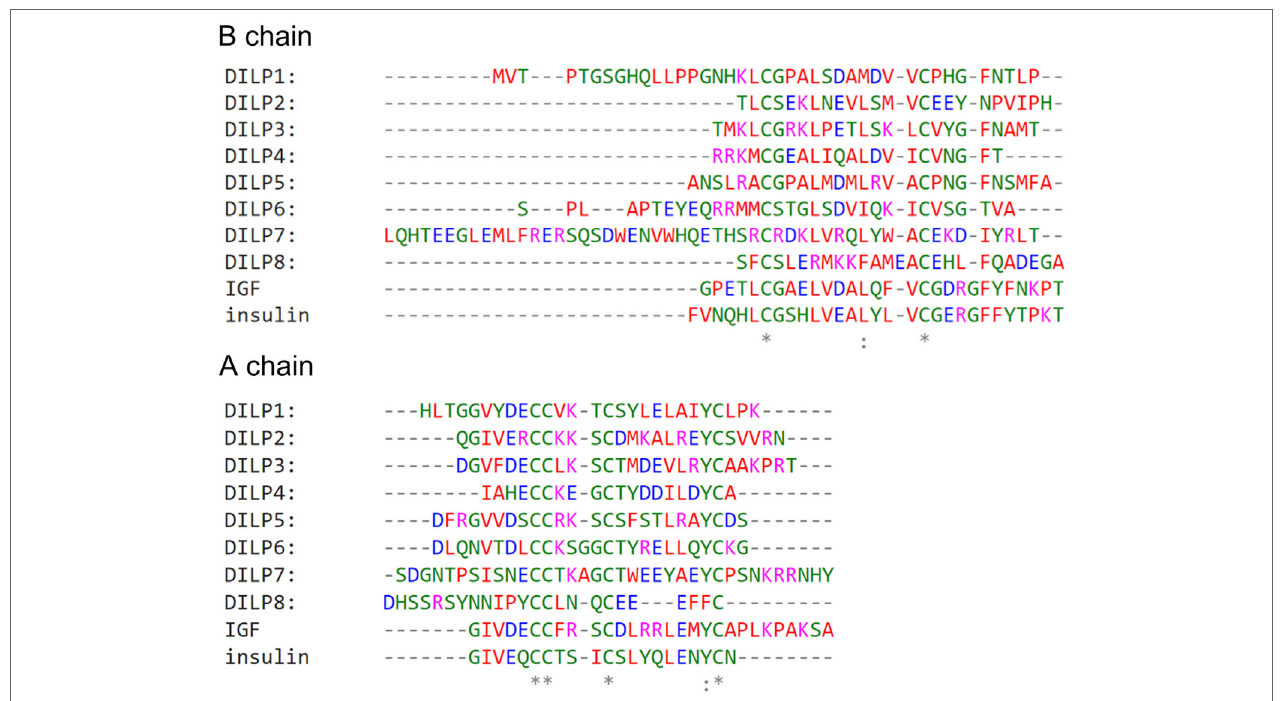
FigUre 1 | Drosophila insulin-like peptide (DILP) amino acid sequences have a low degree of identity between each other and with human insulin and IGF. DILP B chain and A chain sequences based on predicted cleavage sites. Alignment made using EMBL-EBI Clustal Omega